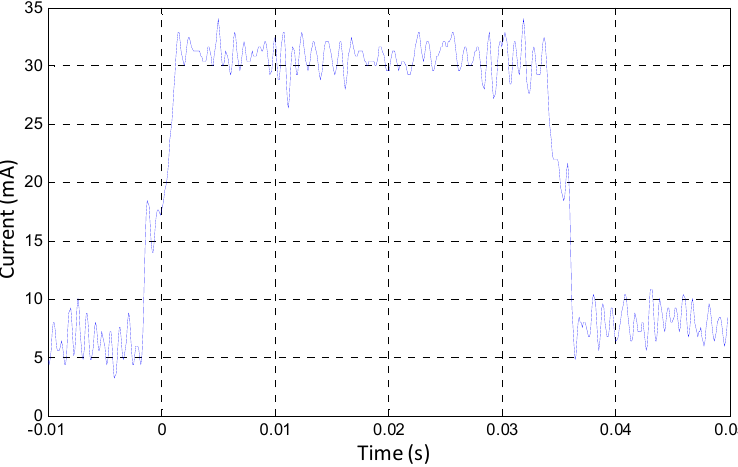
Figure 7. Current profile for a 64 byte transmission at full power (level 7).